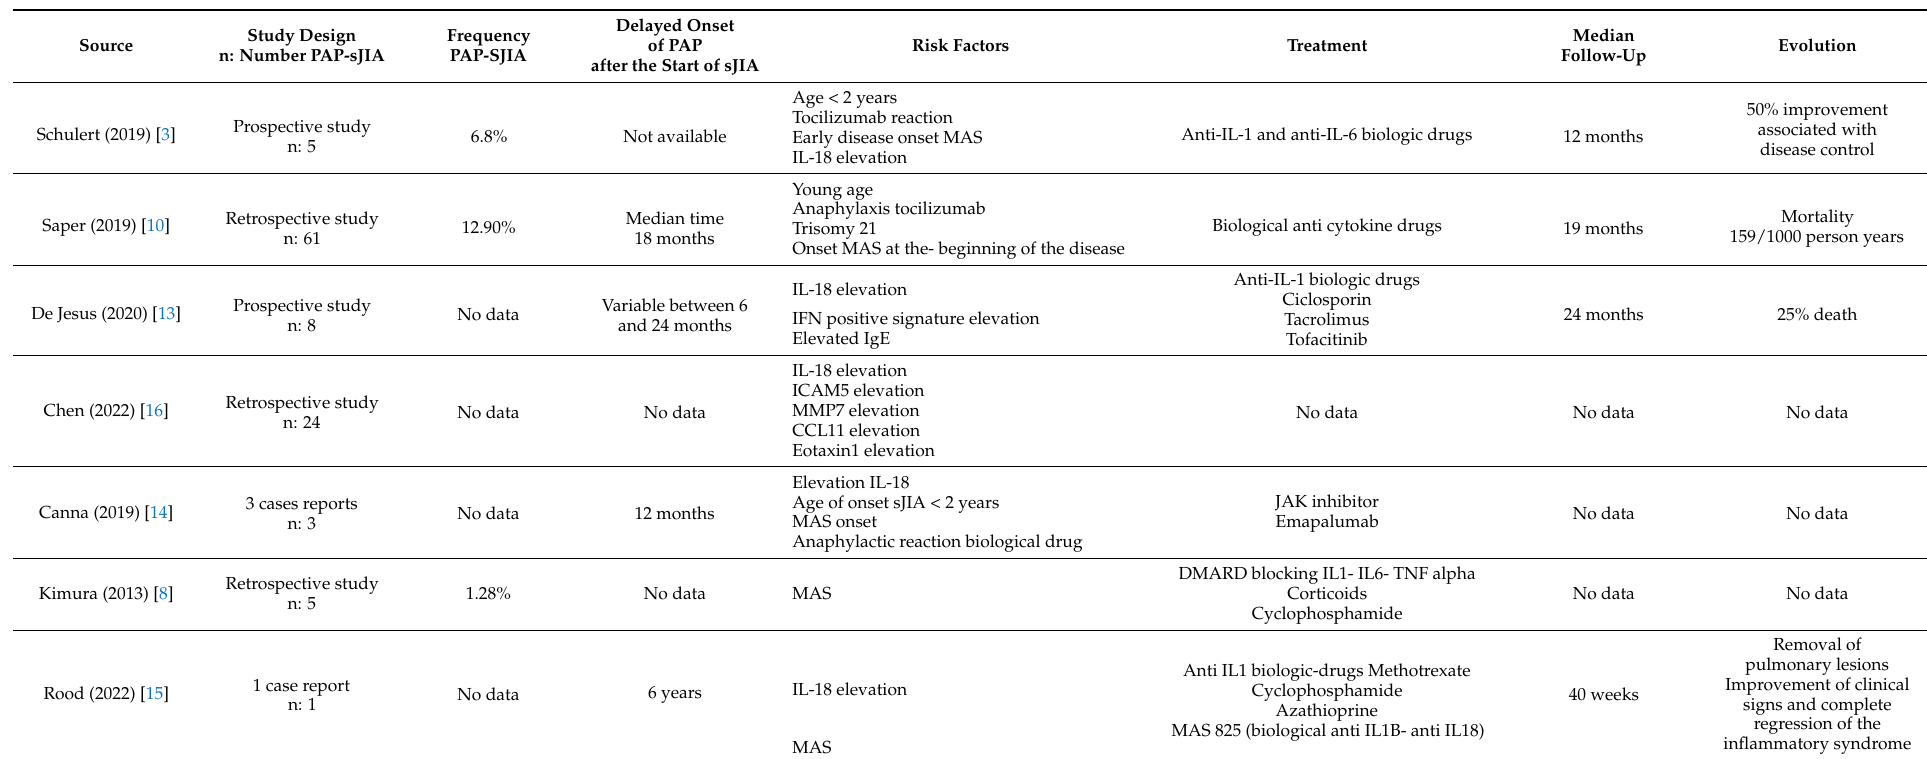
Table 1. Studies reporting the occurrence of PAP in